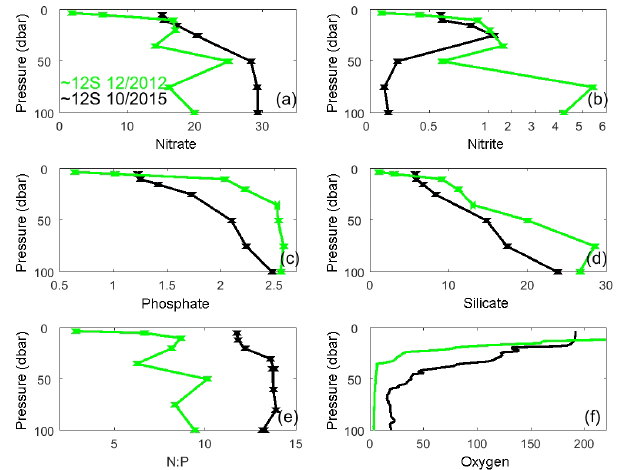
Figure 11. Nutrient profiles at shelf stations with water depth of slightly more than 100m in December 2012 at 12 ◦ 15 (cid:48) S, 77 ◦ 31 (cid:48) W (green) and in October 2015 at 12 ◦ 21 (cid:48) S, 77 ◦ 25 (cid:48) W (black) for (a) nitrate in µmolL − 1 , (b) nitrite in µmolL − 1 , (scale change at 1µmolL − 1 ) , (c) phosphate in µmolL − 1 , (d) silicate in µmolL − 1 , (e) N:P ratio, and (f) CTD oxygen in µmolkg − 1